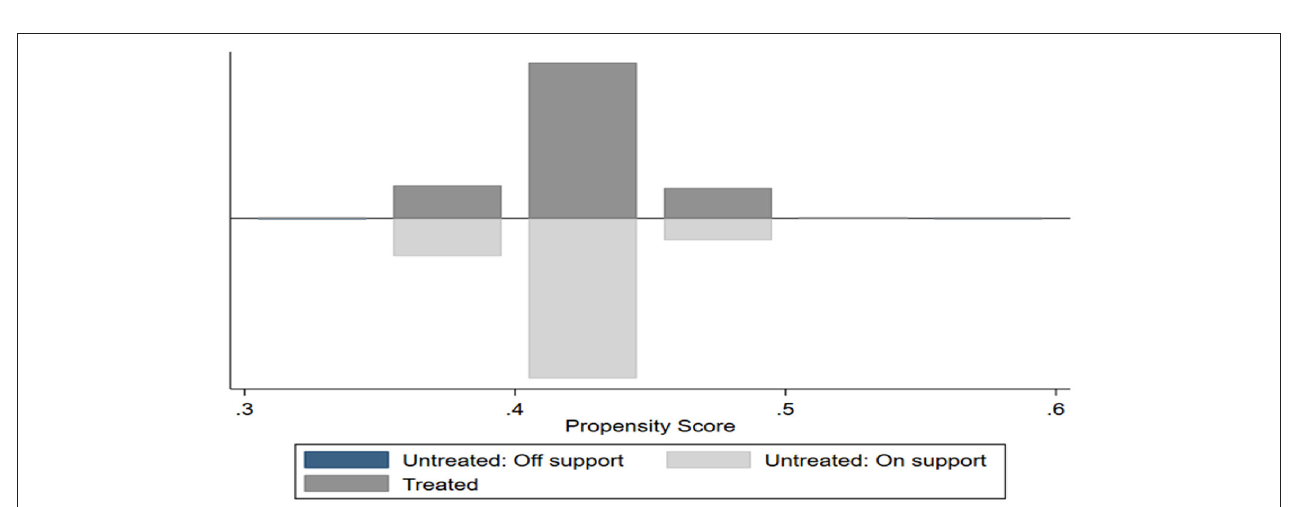
FIGURE 2 | Placebo-controlled test.